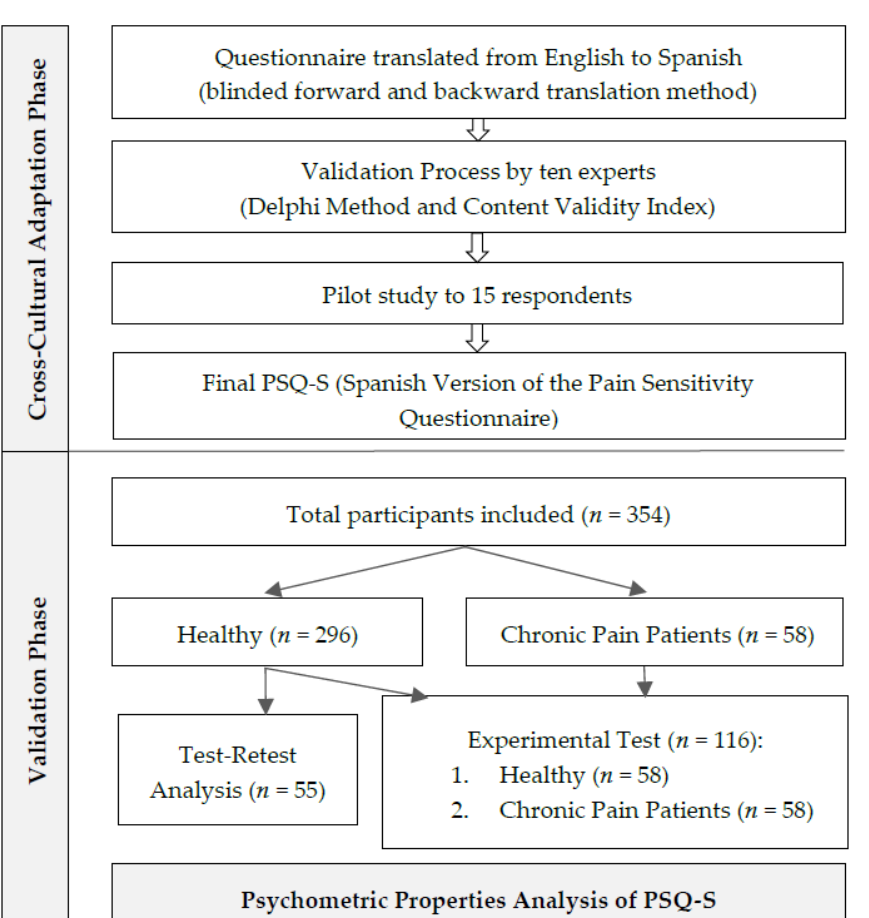
Figure 1. Flowchart of the study.